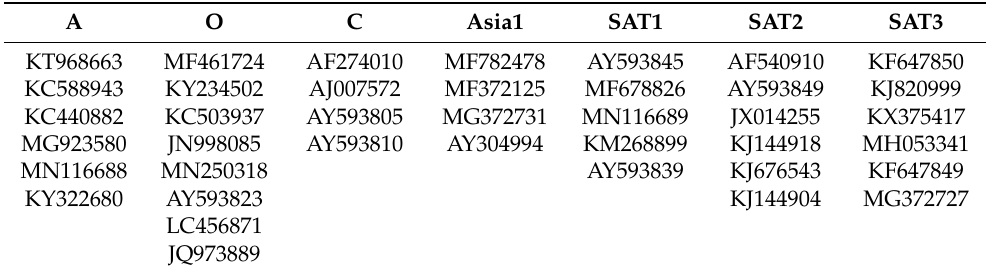
Table 1. Accession number in Genbank for 39 3D genes representing seven serotypes of FMDV. A